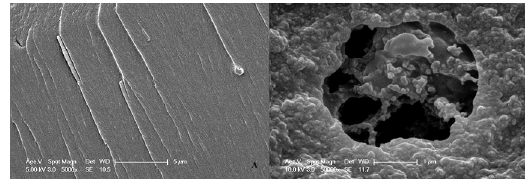
Figure 2: Scanning electron micrographs of (A) the polymeric support (B) immobilized enyzme on polymer.